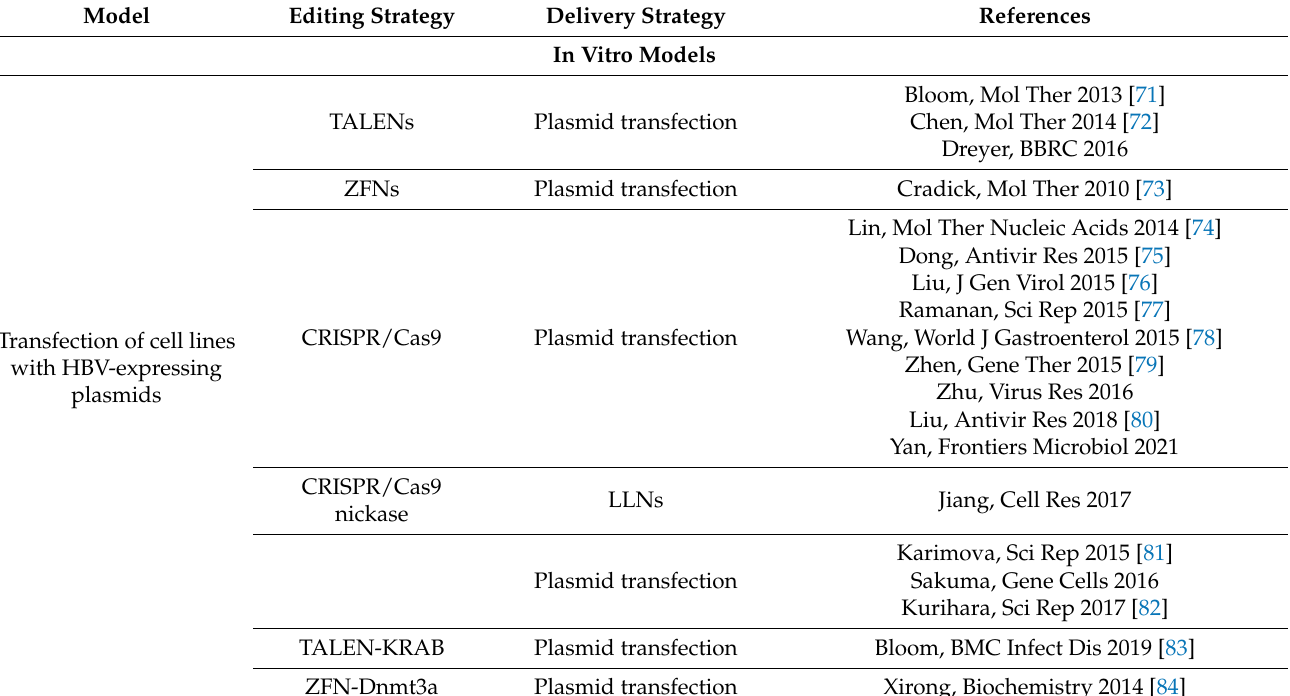
Table 3. Summary of published HBV editing